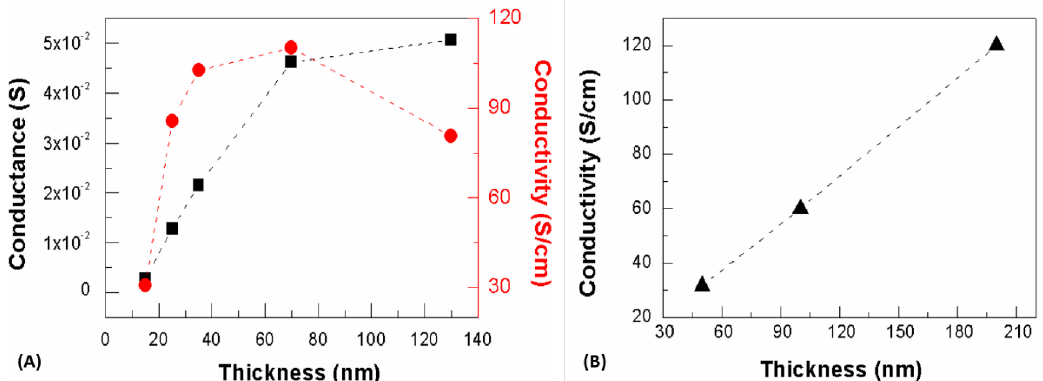
Figure 3. ( A ) Conductance (black squared symbols) and conductivity (red circles) as a function of the device channel thickness for long-lasting thermal annealing (LTA) processing; ( B ) Conductivity versus channel thickness for films processed under rapid thermal annealing (RTA) conditions.